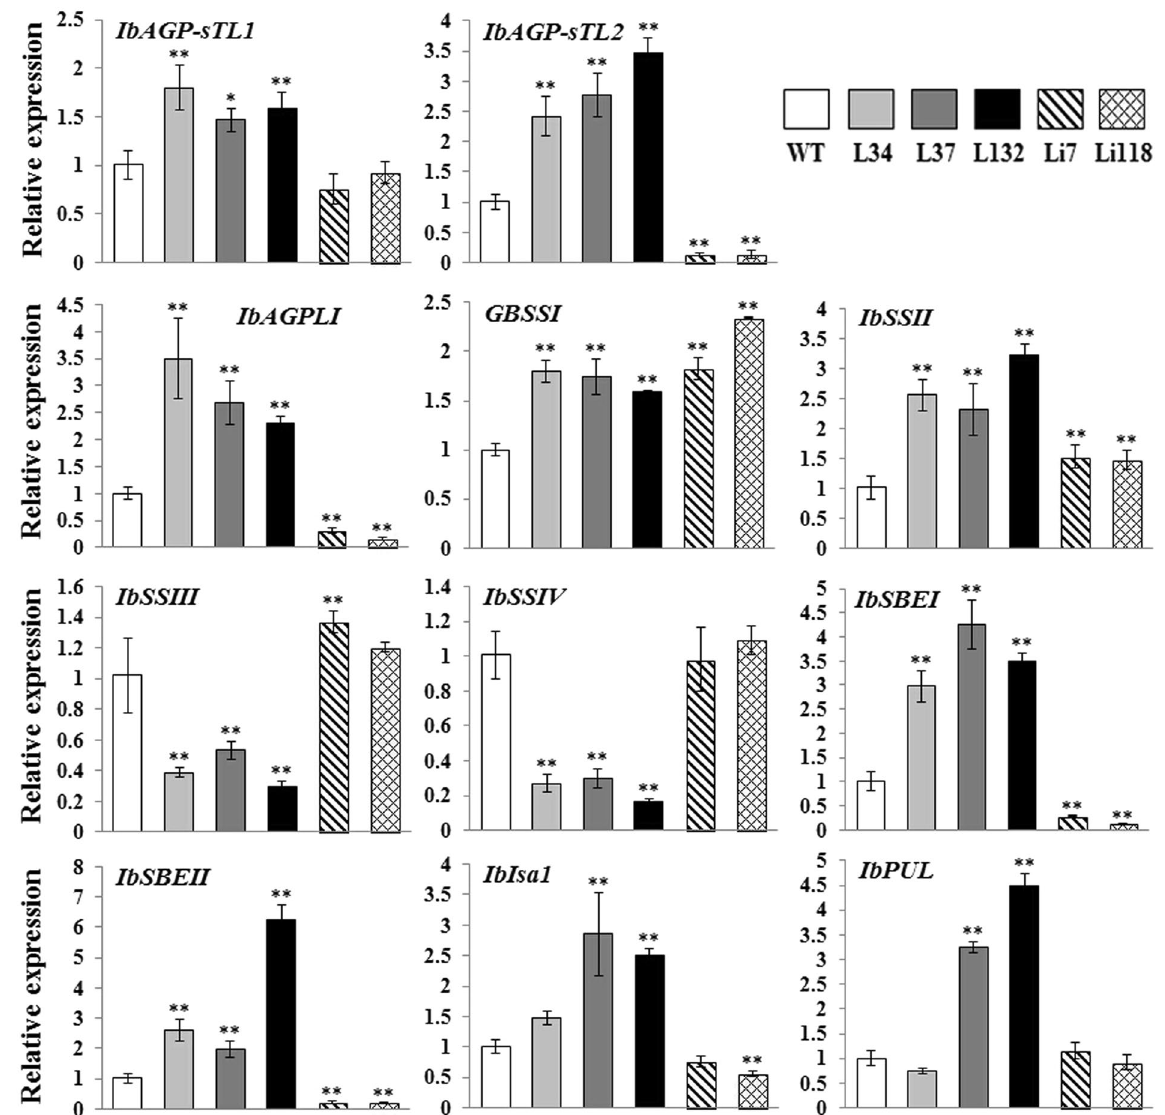
means ± SD (n = 3). * And ** Indicate a significant difference versus WT at P < 0.05 and < 0.01, respectively, based on Student’s t